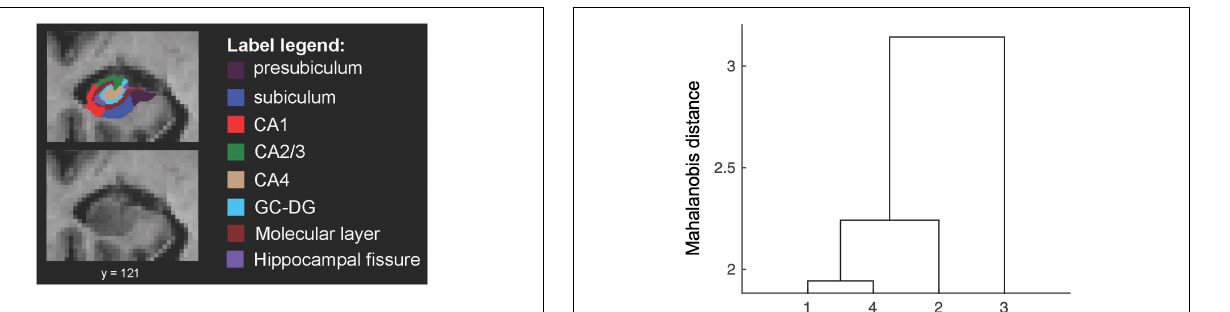
FIGURE 1 | Spatial definition of hippocampal subfields by 7 Tesla MP2RAGE. Coronal view of right-hemispheric hippocampal subfield segmentation (radiological convention) from one example subject, defined by using FreeSurfer V6.0 for segmentation of high resolution 7 Tesla MP2RAGE volumes. CA, cornu ammonis; GC-DG, granule cell layer of the dentate gyrus.